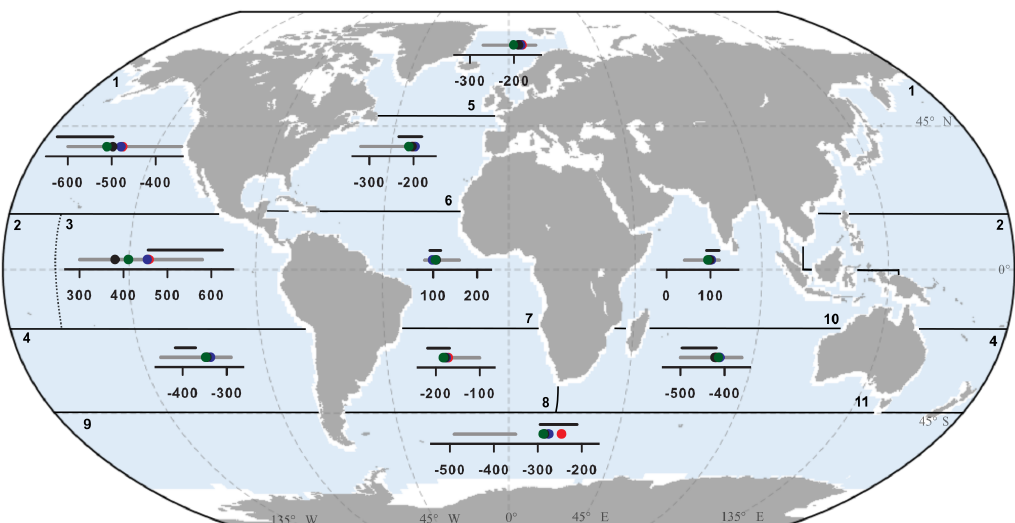
Figure 5. Spatial extent of the 11 RECCAP regions used for our regional analysis. In each regions the range of uncertainties in F CO 2 (TgCyr − 1 ) is represented as calculated by the different RECCAP studies (grey lines; Ishii et al., 2014; Lenton et al., 2013; Sarma et al., 2013; Schuster et al., 2013) and by Zscheischler et al. (2017, black lines) for the 1990–2009 and 2001–2010 periods, respectively. These ranges are represented by the median absolute deviation (MAD). Points correspond to the F CO 2 (TgCyr − 1 ) calculated in our study with a quadratic k relationship where c is recalibrated for each wind product to fit a global average k value of 16cmh − 1 for the 1991–2011 period ( c ∗ ). F CO 2 points calculated with CCMP, ERA, NCEP1 and NCEP2 are represented in red, blue, black and green, respectively. In region 5, the F CO 2 range calculated by Zscheischler et al. (2017) is not represented because they take into account the Arctic region which is not include in our